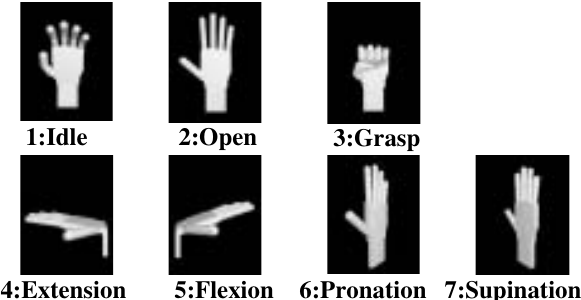
Figure 5 Subject gestures.